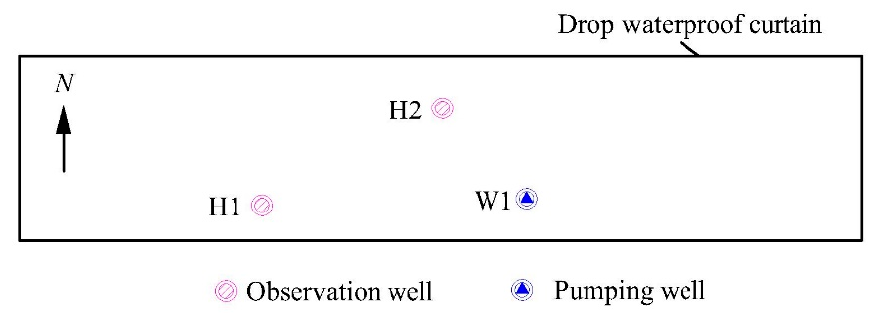
Figure 4. Schematic diagram straight-line method.